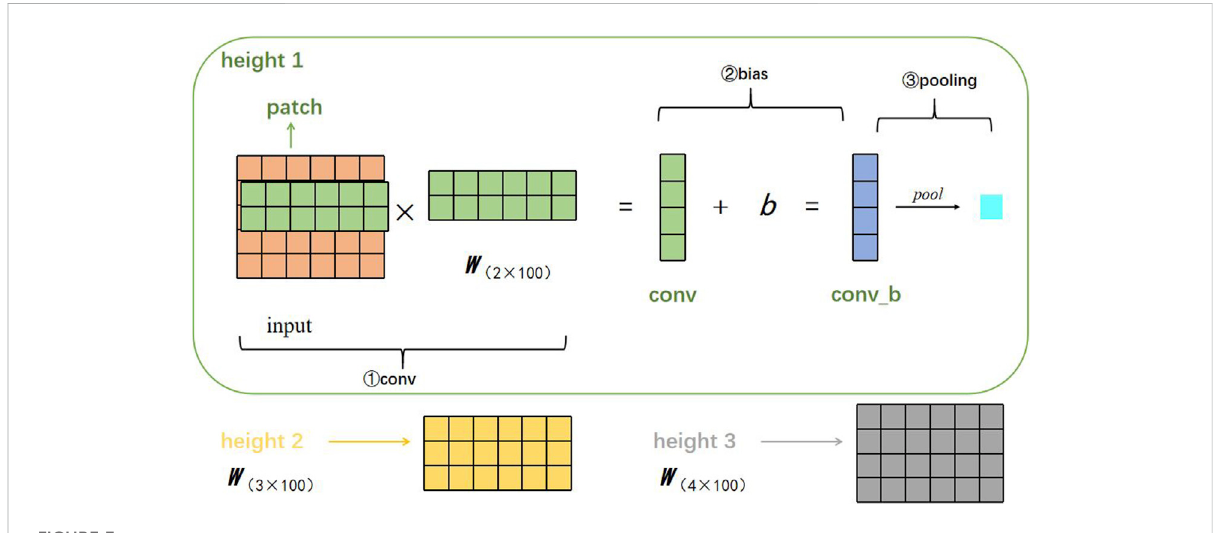
FIGURE 3 Visualization of the corresponding convolution calculation